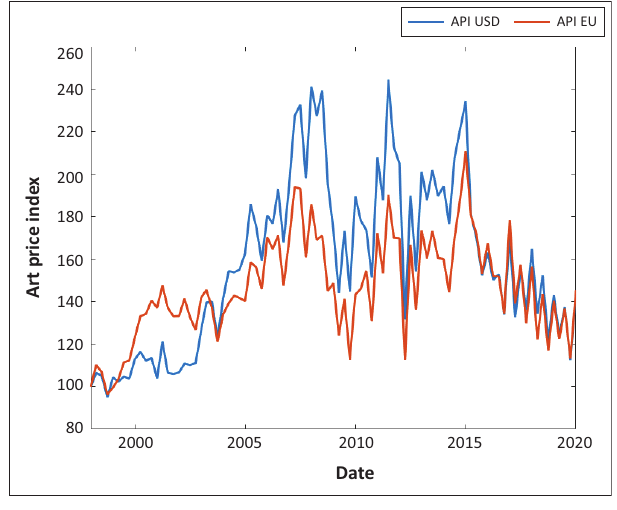
FIGURE 5: Global Art Price Index in United States Dollars European Euros